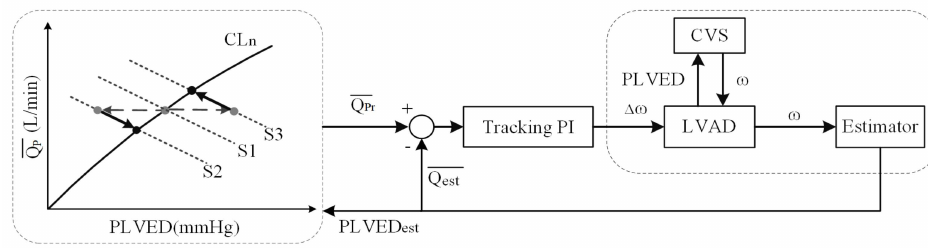
Figure 2. Block diagram of the control system. CVS, reference cardiovascular system; LVAD, left ventricular assist device; ω , motor speed; Q est , estimated average pump flow; PLVED, left ventricular end-diastolic pressure; Q Pr , desired average pump flow; PI, proportional and integral controller; CLn, Control Line; S1, original state; S2 and S3, deviated states. Gray circles represent the position of operating points after a change in states. Black circles represent the positions of operating points upon arriving at the new steady-state located at the intersection between the control line and the new system line. The controller drives the changes in the operating points along the path indicated by the arrows along the new system